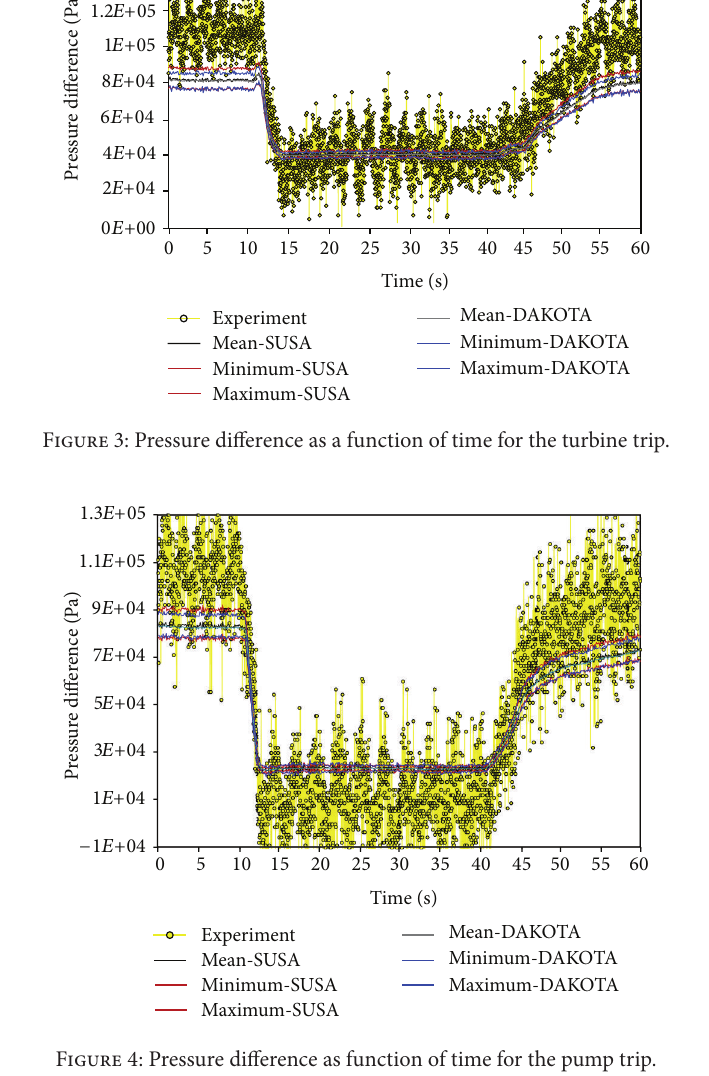
Figure 4: Pressure difference as function of time for the pump